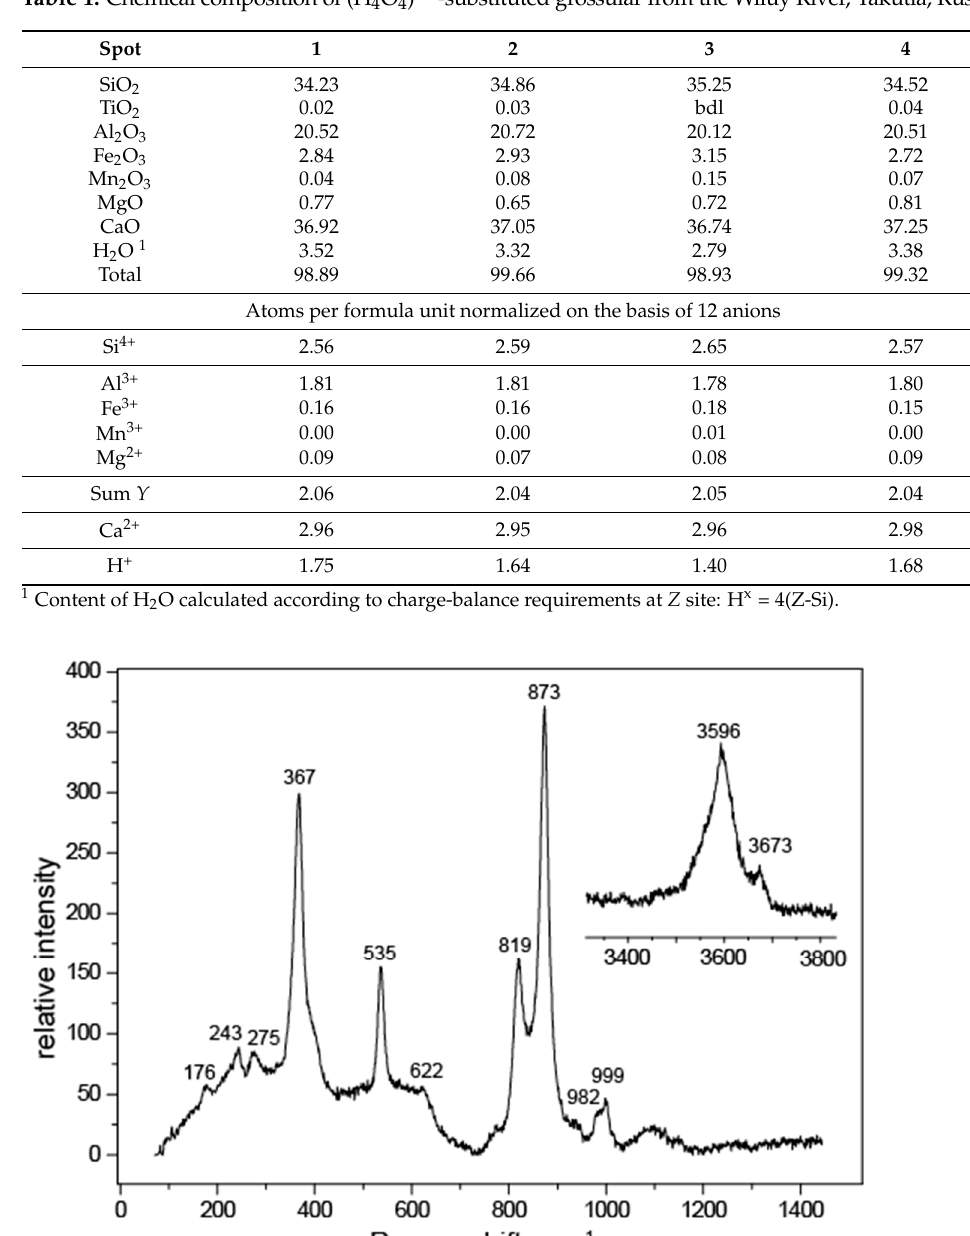
Table 1. Chemical composition of (H 4 O 4 ) 4 − -substituted grossular from the Wiluy River, Yakutia, Russia.